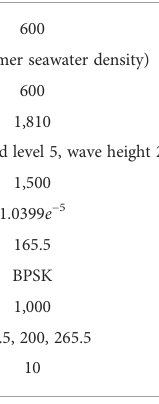
TABLE 2 The parameters of the marine